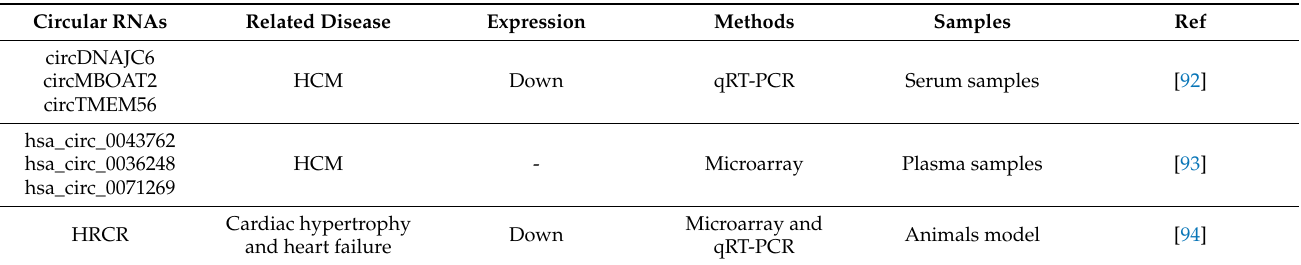
Table 2. The circular RNAs involved in hypertrophic cardiomyopathy. Circular RNAs Related